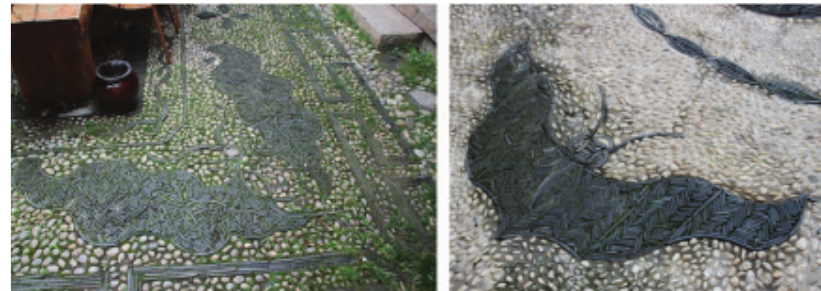
Figure 12 . Pavement with patterns of bats (photos by the fi rst author)